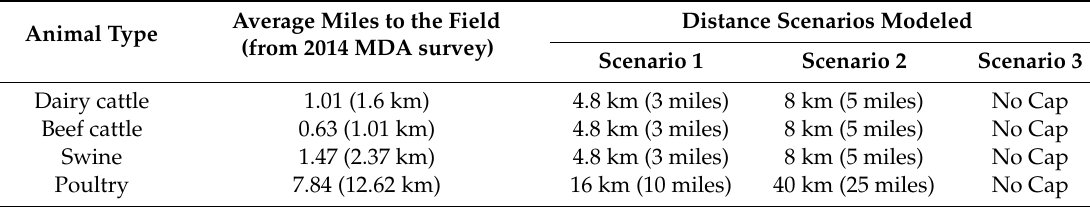
Table 5. Distance Scenarios Modeled and 2014 Survey Results on Average Distance to Field. Animal